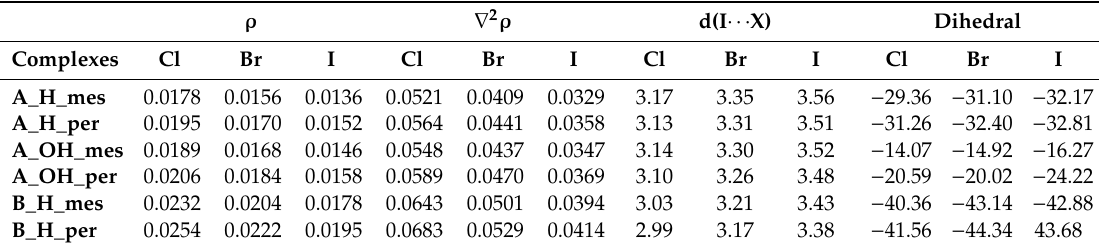
Table 2. Electron density at the BCP ( ρ ), Laplacian ( ∇ 2 ρ ), and interaction distance (Å) for all